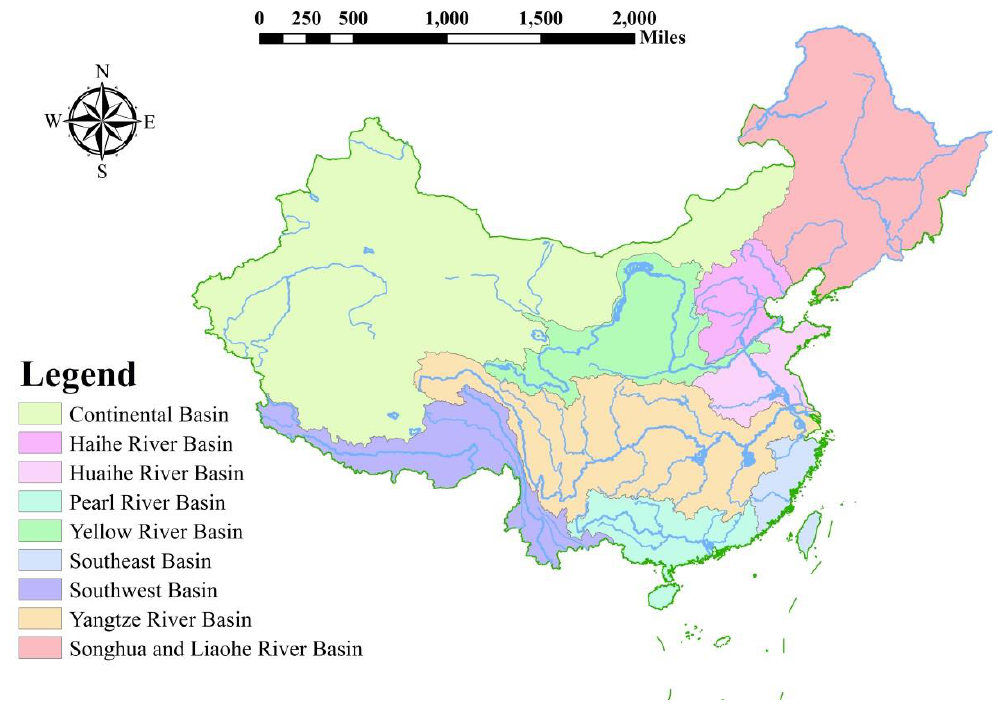
Figure 3. China’s major river basins.